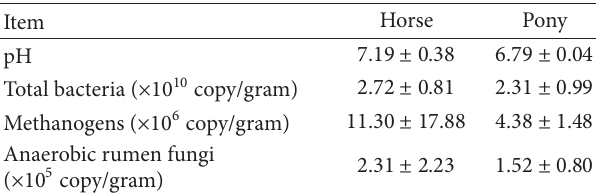
Table 2: pH and population densities (copy numbers per gram wet weightoffeces)ofanaerobicrumenfungi,methanogen,andbacteria in feces of the horse and